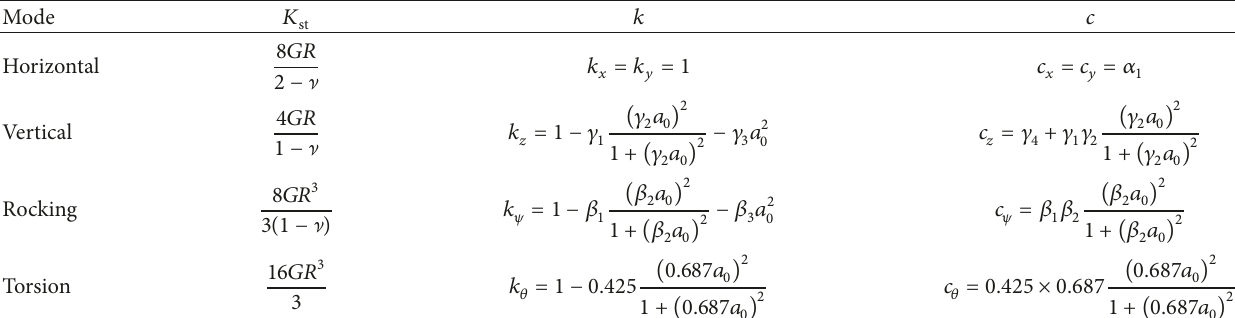
Table 1: Soil impedance functions for circular foundation on a half-space [23].